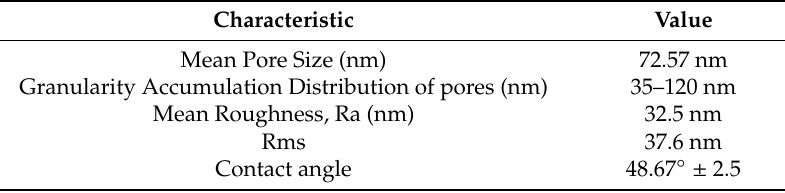
Figure 5. Surface characteristics of the nanocomposite membrane ( A ) SEM cross-section, ( B ) SEM surface, ( C ) AFM, and ( D ) granularity cumulation distribution of pores. Table 2. 1.5 PPSU/ZnO membrane surface characteristics.